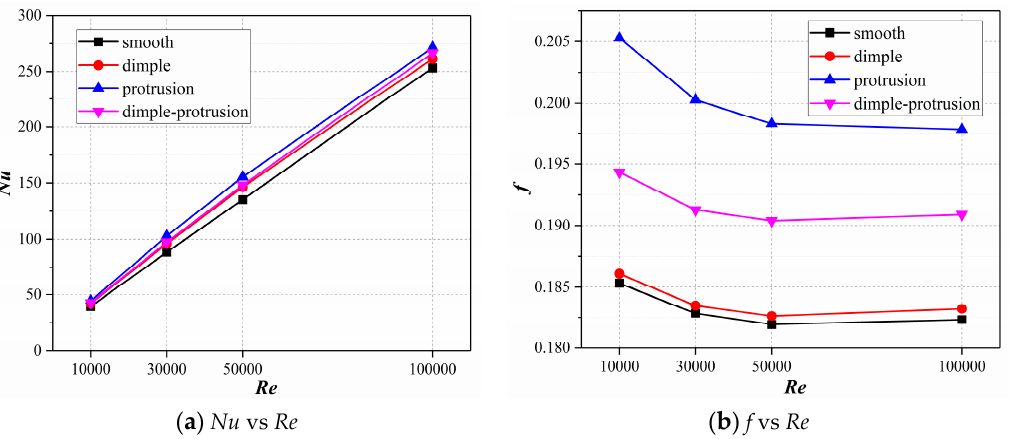
Figure 11. Variations of Nusselt number and friction with Re for different dimple/protrusion arrangements.